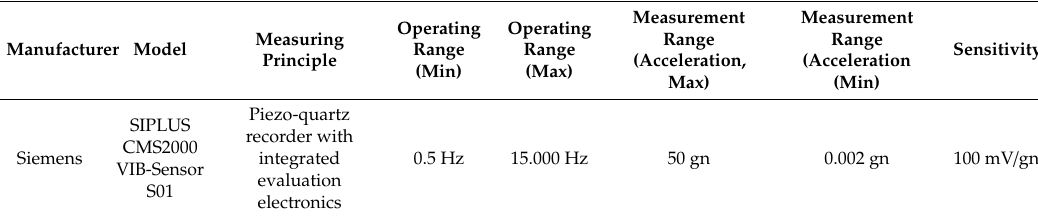
Table 1. Technical parameters of the vibration sensor.